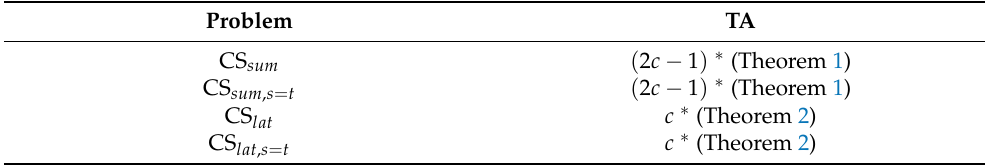
Table 1. Overview of our results for ride-sharing problems with c ≥ 2.